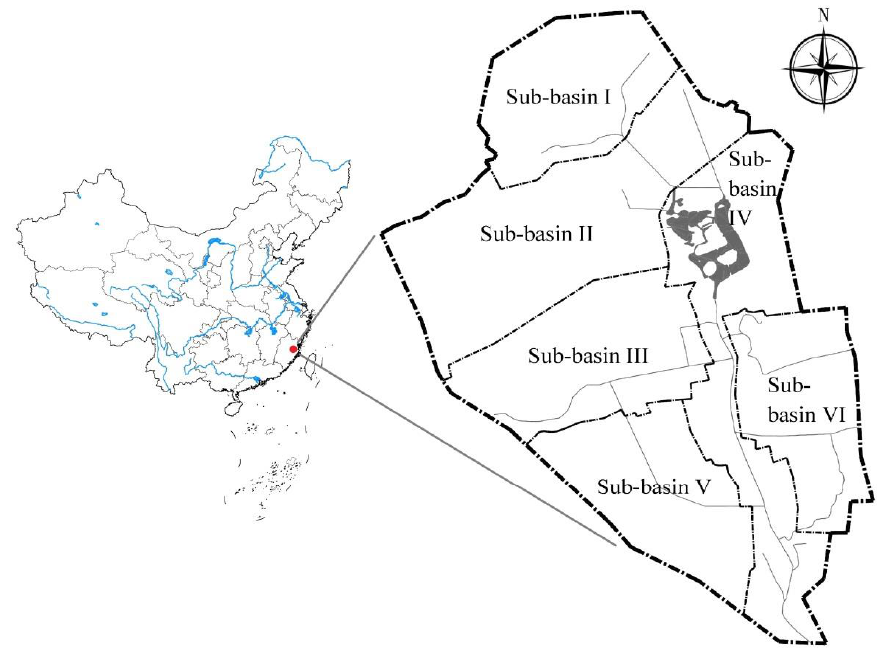
Figure 1. Six sub-basins in Fuzhou, China. Table 2. General characteristics of selected six sub-basins in Fuzhou.